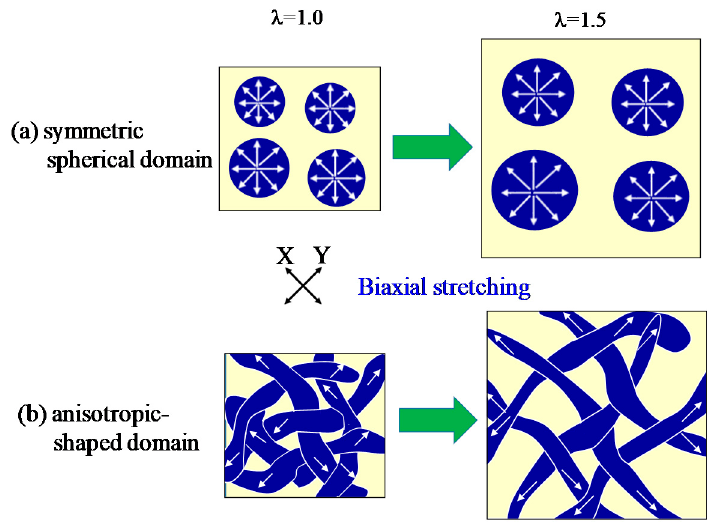
Figure 4. Schematic illustration for the deformation direction of the two-phase structure by simultaneous biaxial stretching. ( a ) symmetric spherical domain; ( b ) anisotropic-shaped domain.